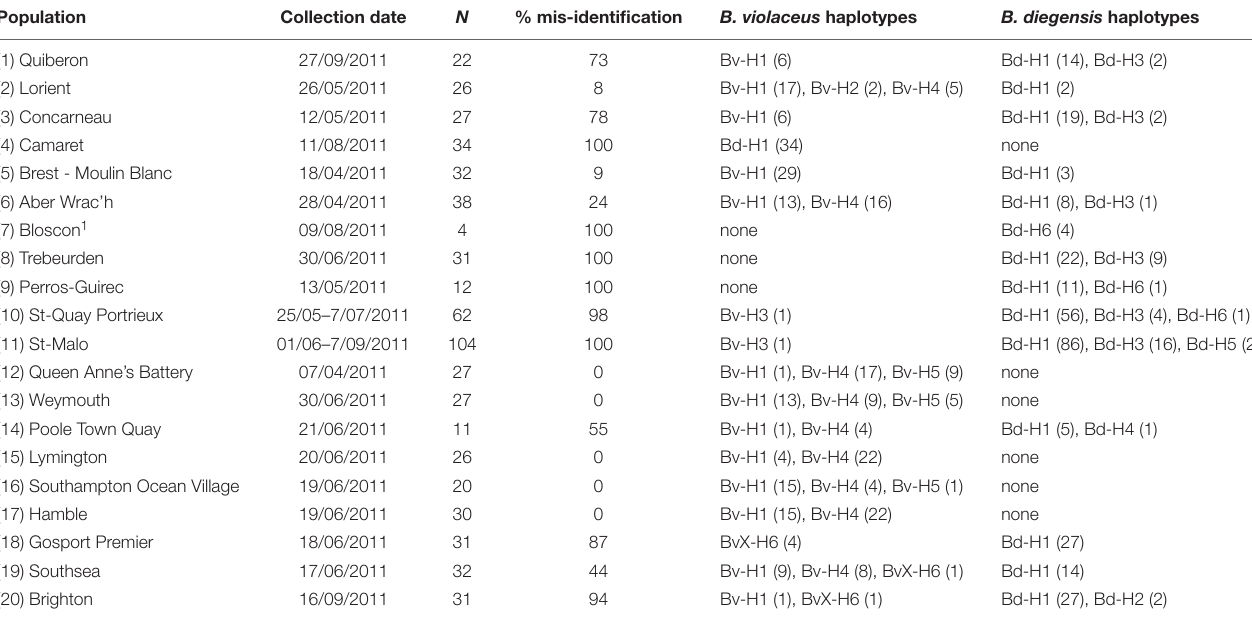
TABLE 1 | Population sampling, proportion of mis-identification (based on COI sequencing) and haplotype counts.